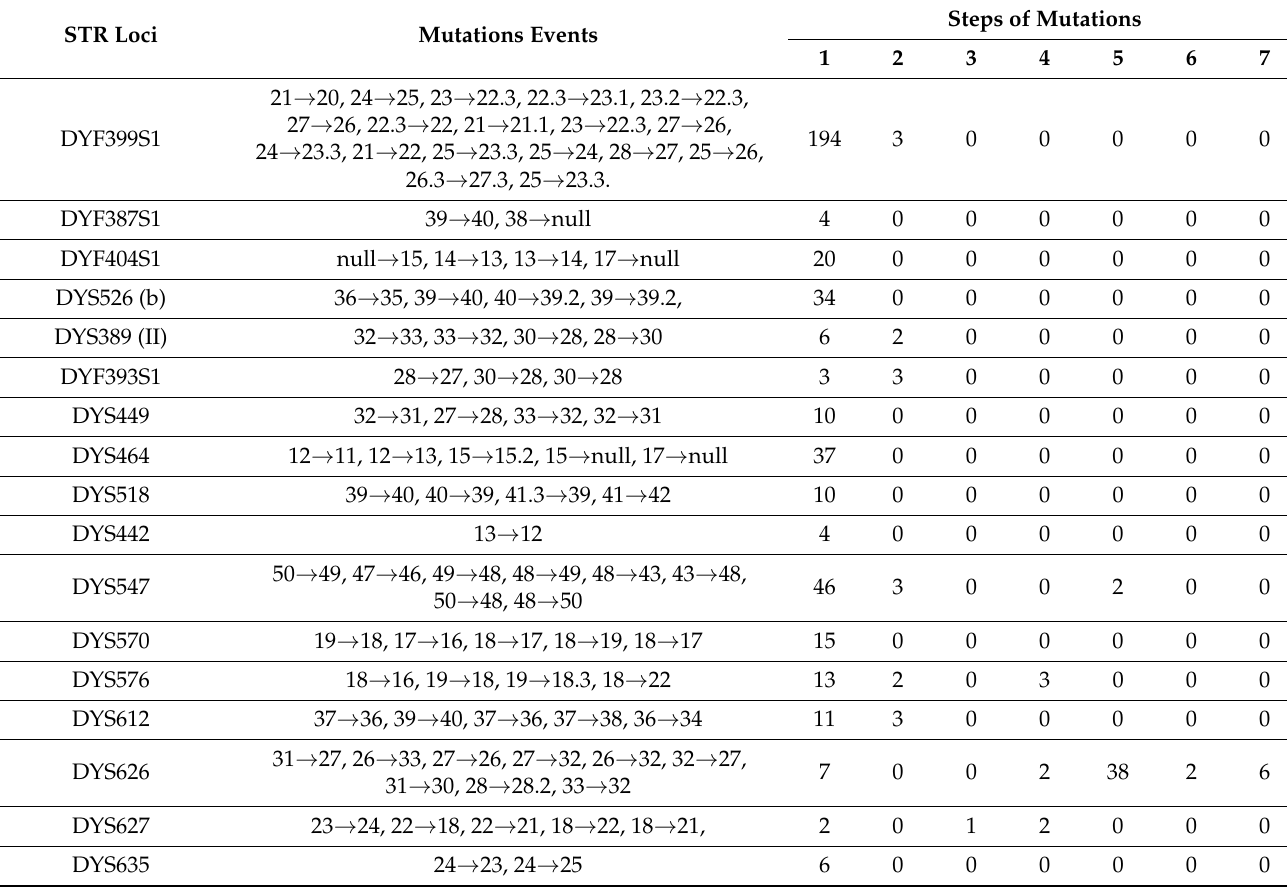
Table 4. Mutation events observed at various RM Y STR loci. STR Loci Mutations